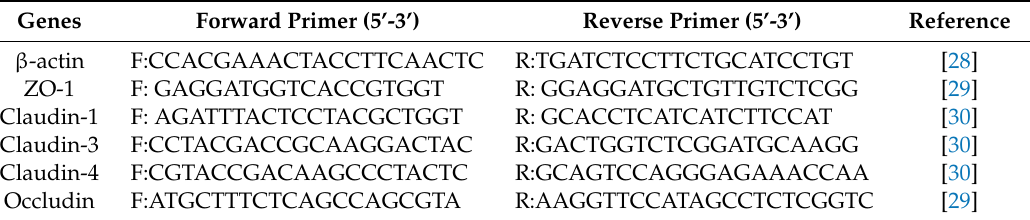
Table 1. Lists of primers used in this